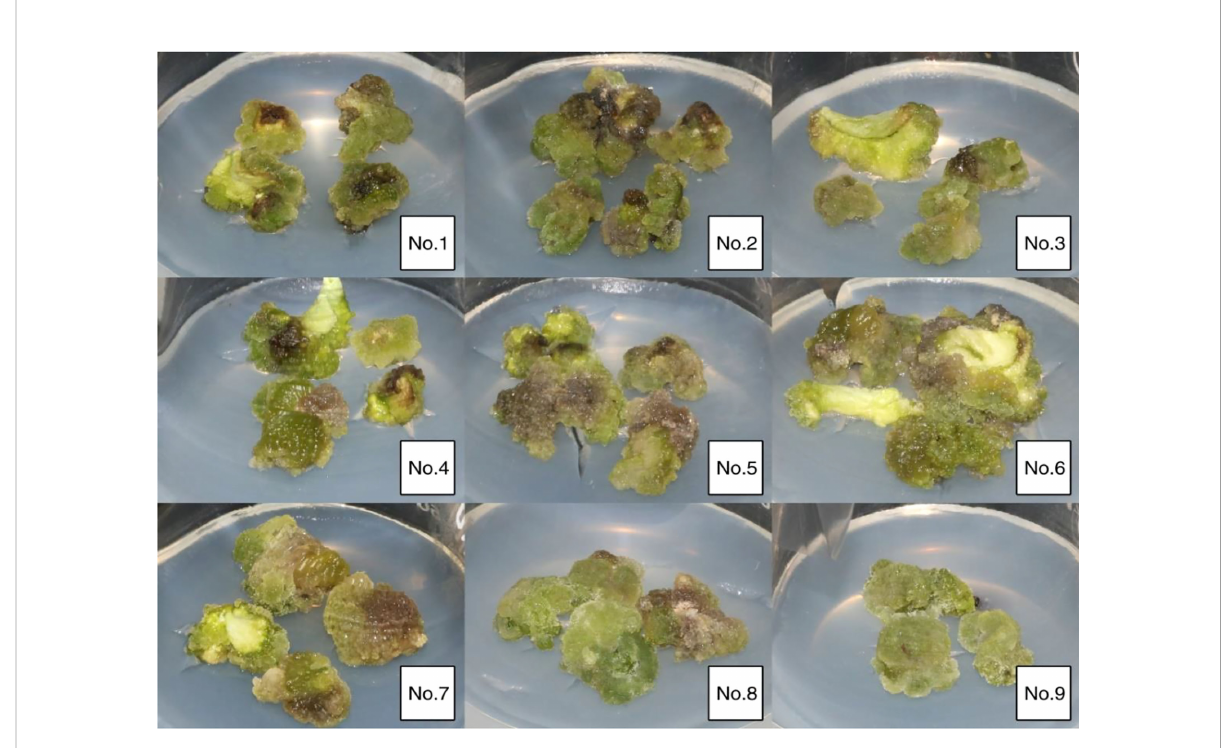
FIGURE 3 Growth of callus induced by cotyledons germinated from 80-day embryos in vitro on different media.